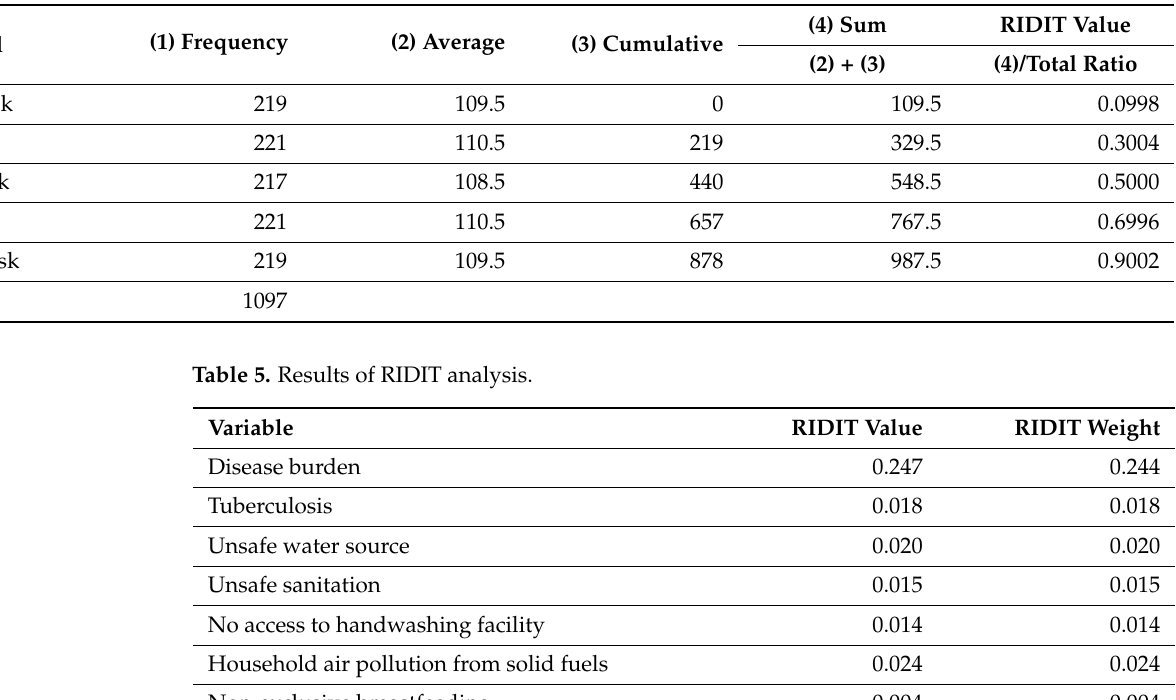
Table 4. Process of RIDIT analysis.